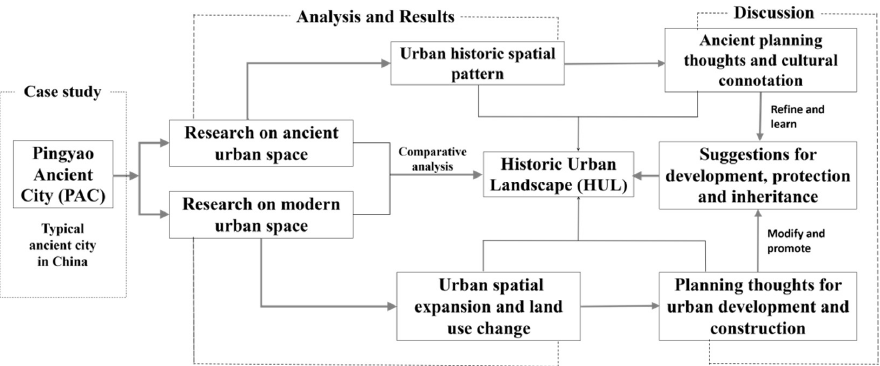
Figure 1. Research framework.